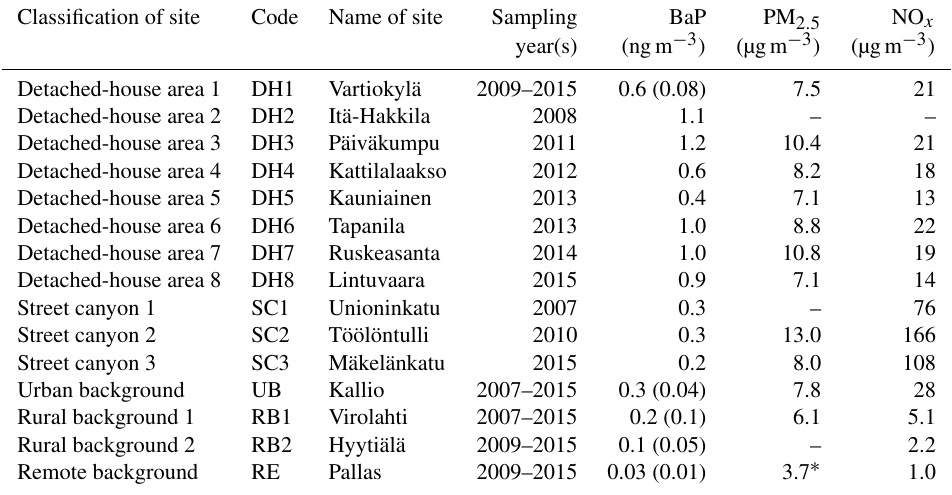
Table 1. Information on the measurement sites, and mean BaP, PM 2 . 5 , and NO x concentrations and standard deviations between the years in